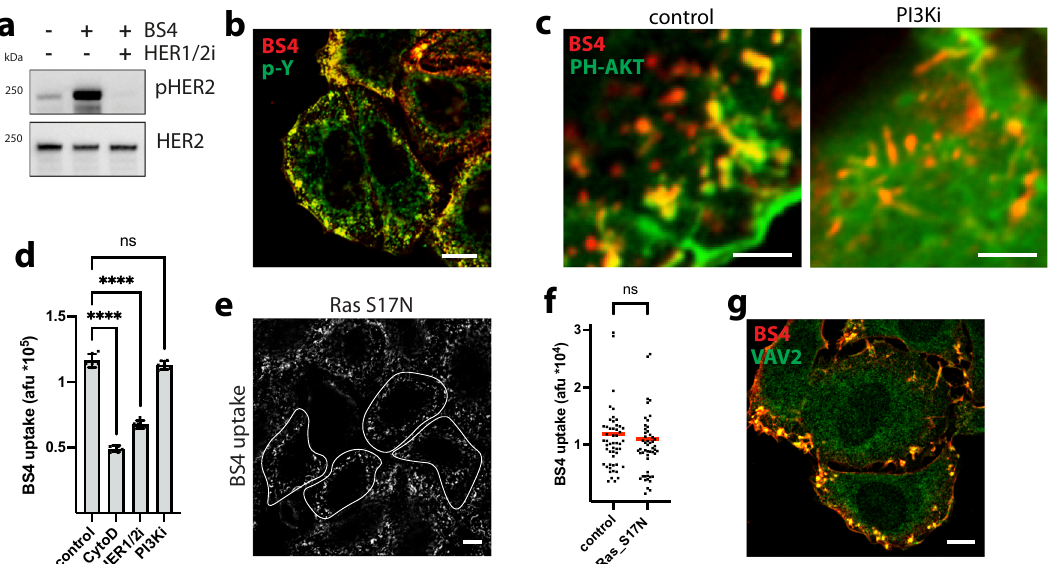
Fig. 7 | BS4-triggeredADE ofHER2isindependent ofRasand PI3K. BS4induces HER2 autophosphorylation ( a, b ). SkBr3 cells±dual EGFR/HER2 kinase inhibitor lapatinib(HER1/2i) wereincubatedwith BS4for2.5min asindicated.Samples were analysedbyimmunoblotfortotalHER2andphospho-HER2(pHER2)( a ).SkBr3cells were incubated with BS4-dylight650 (red) for 2.5min, after fi xation stained for phosphorylated tyrosine residues (p-Y, green) and analysed by confocal micro- scopy( b ).LocalisationofPIP3toBS4-inducedHER2aggregates( c ).SkBr3cellswere transfected with a vector expressing the PIP3 sensor PH-AKT-GFP (green) for 16h treatedornotwiththePI3KinhibitorLY294002(PI3Ki)followedbyincubationwith BS4-dylight650 (red) for 2.5min. After fi xation samples were analysed by confocal microscopy.BS4uptakeisreducedbyHER2kinasebutnotPI3-kinaseinhibition( d ). SkBr3 cells were treated with CytoD, lapatinib (HER1/2i) or LY294002 (PI3Ki) as indicatedand incubated with BS4-dylight650 for 30min. After fi xation BS4uptake was quanti fi ed by fl ow cytometry; means±SD, n =6 independent experiments, ns